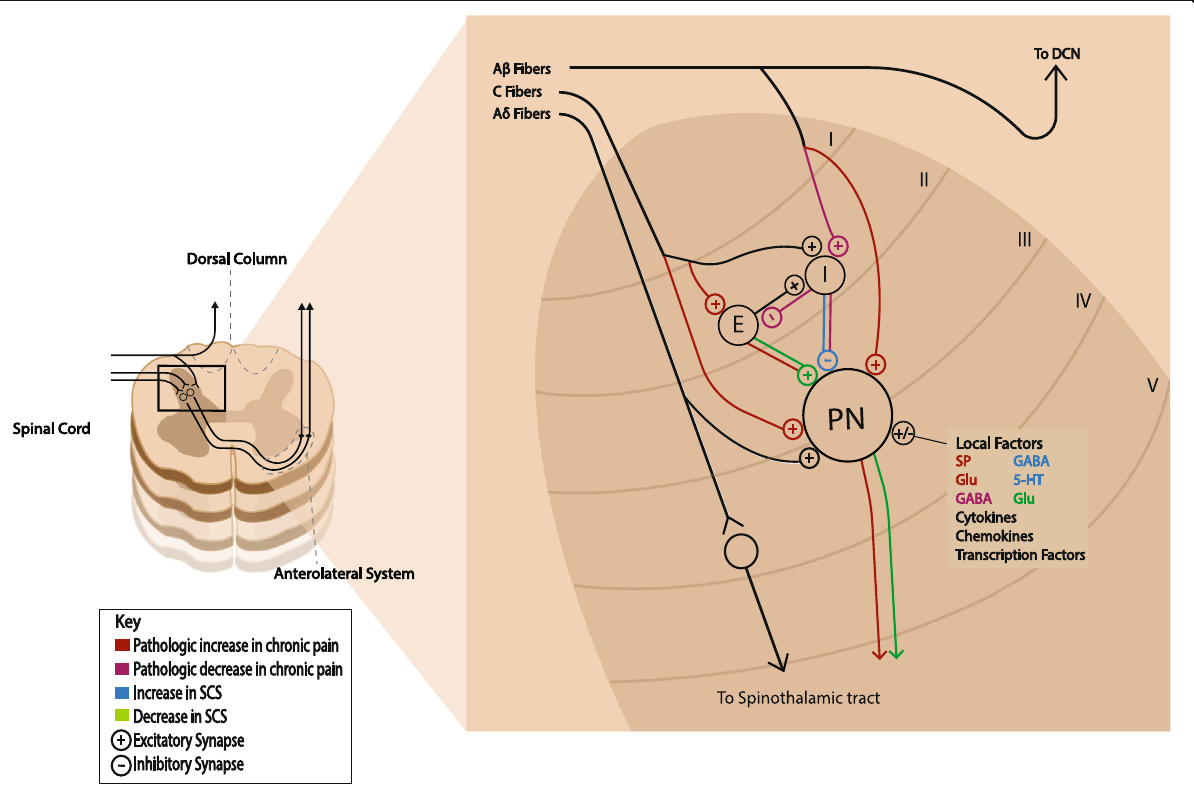
Fig. 4 Changes in Dorsal Horn Circuitry to chronic pain and SCS. In the development of chronic pain, neural circuitry undergoes rewiring wherein abnormal enhancement of excitatory pathways and loss of inhibition facilitate nociceptive transmission to sub-threshold stimuli. Increased excitatory interneuron input, decreased inhibitory interneuron input and local factors contribute to pathologic destabilization of normal input balance to the projection neuron. SCS changes the balance of nociceptive and antinociceptive inputs through the activation of local segmental and descending supraspinal mechanisms to in-part restore balance to this network. Acronyms: DCN (Dorsal Column Nuclei), E (Excitatory Interneuron), I (Inhibitory Interneuron), PN (Projection Neuron), SP (Substance P), Glu (Glutamate), GABA (Gamma Aminobutyric Acid),